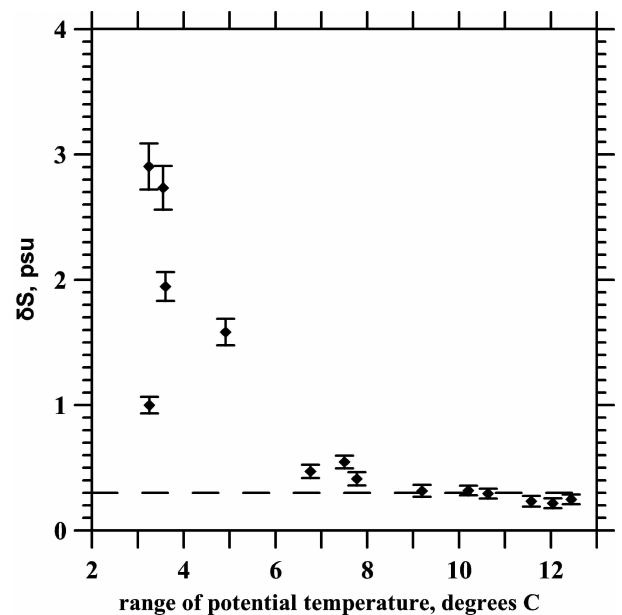
Fig. 5. The dependence of the width of the salinity confidence in- tervals δS on the range of potential temperature values used in each polynomial fit is presented. The dashed line represents the level δS = 0 . 3psu, where the confidence intervals appear to become in- dependent of the range of potential